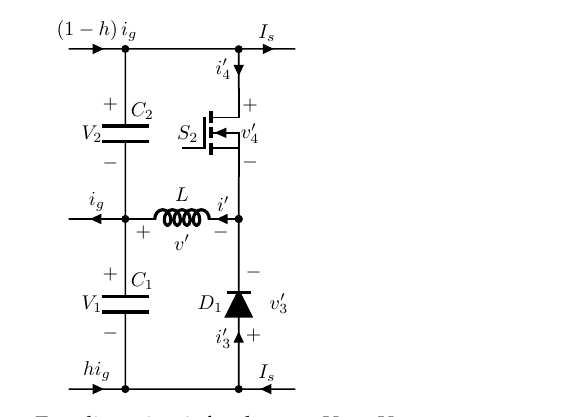
Figure 7. Equalizer circuit for the case V 2 > V 1